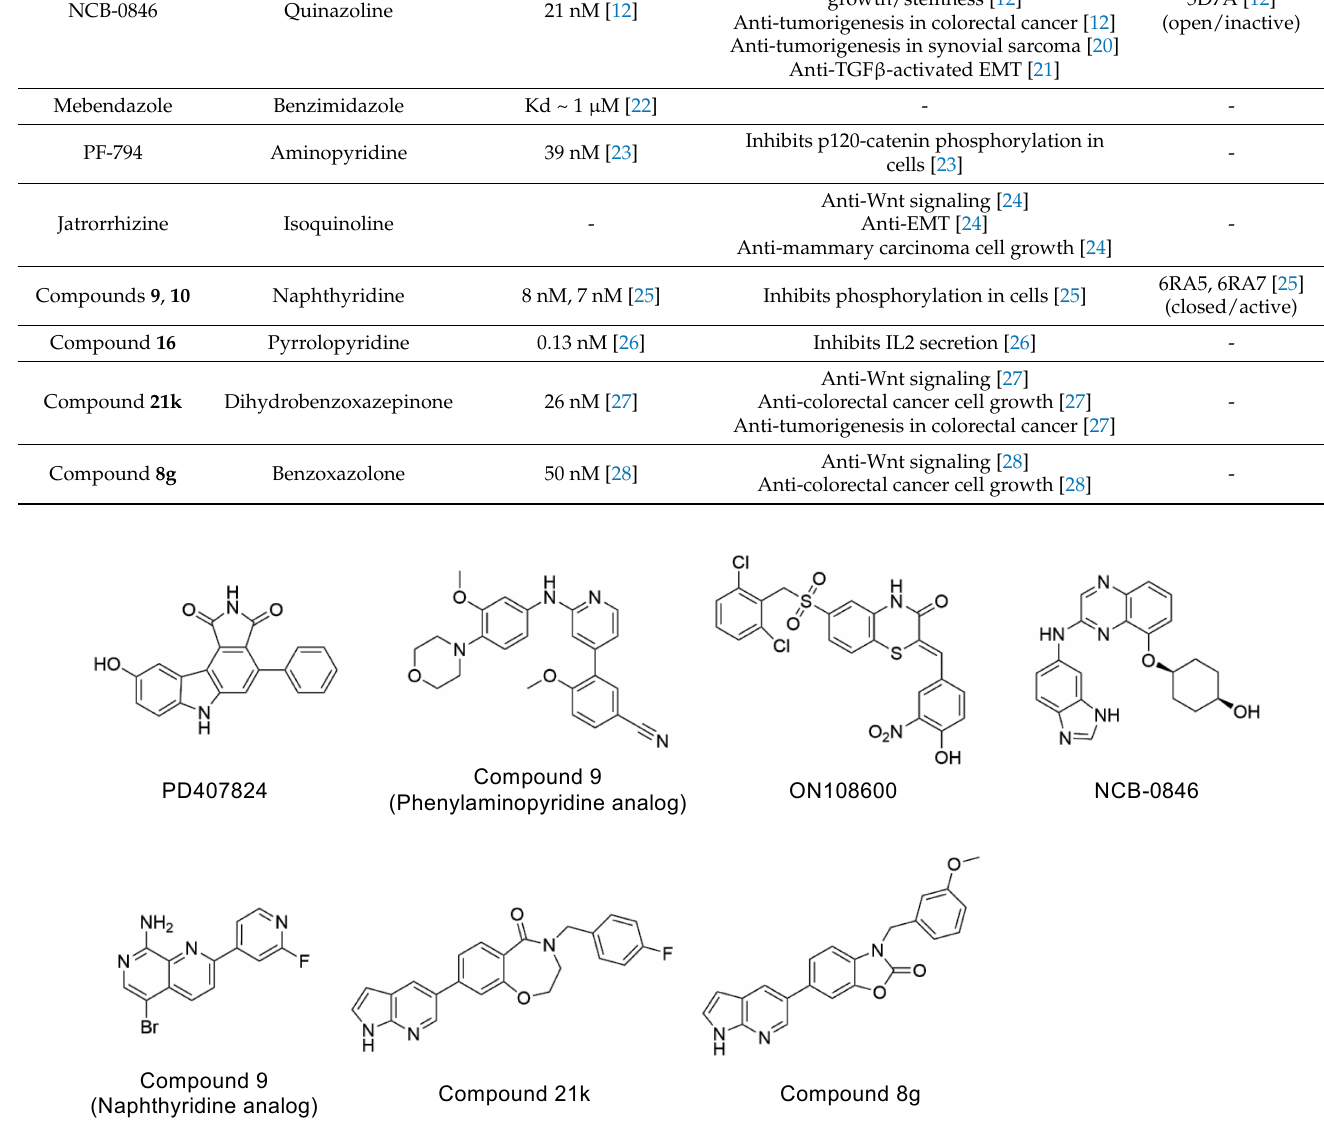
Figure 2. Chemical structures of representative TNIK inhibitors.